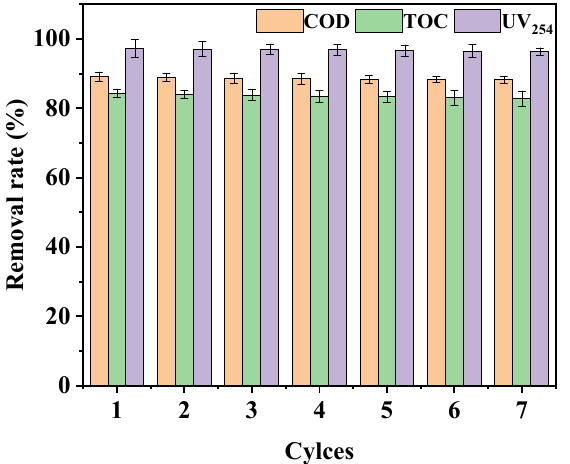
Figure 15. Effect of repeated use of catalyst on catalysis. (Reaction conditions: LaCoO 3 /CeO 2 = 1 g/L, H 2 O 2 = 40 mM, 120 ◦ C, 0.5 MPa, 60 min).